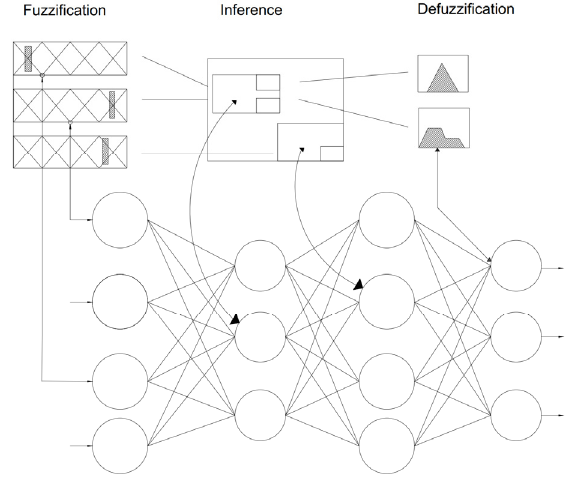
Figure 6. The process of learning and processing information of the Neural-Fuzzy system.